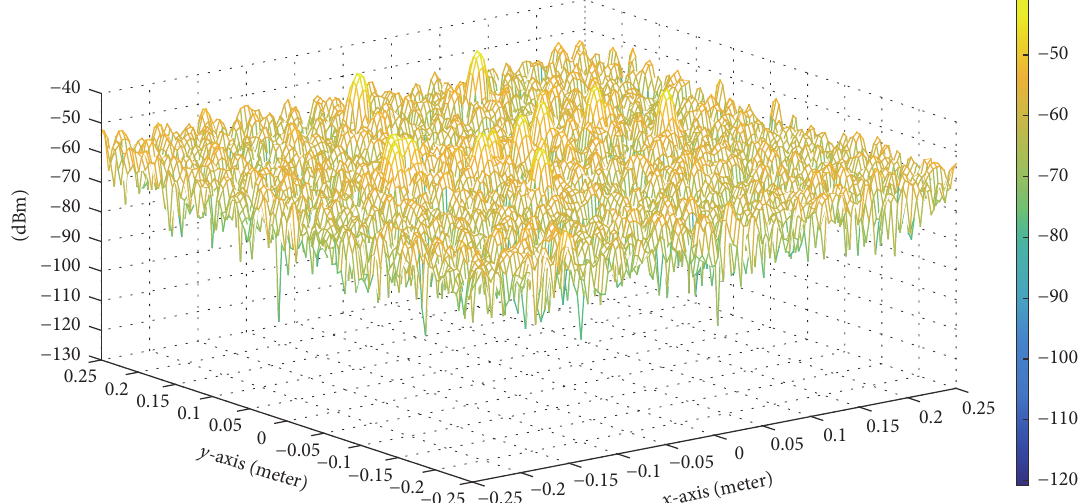
Figure 9: The power distribution of the contrast function, showing the reflected power over measurement domain before applying MRL